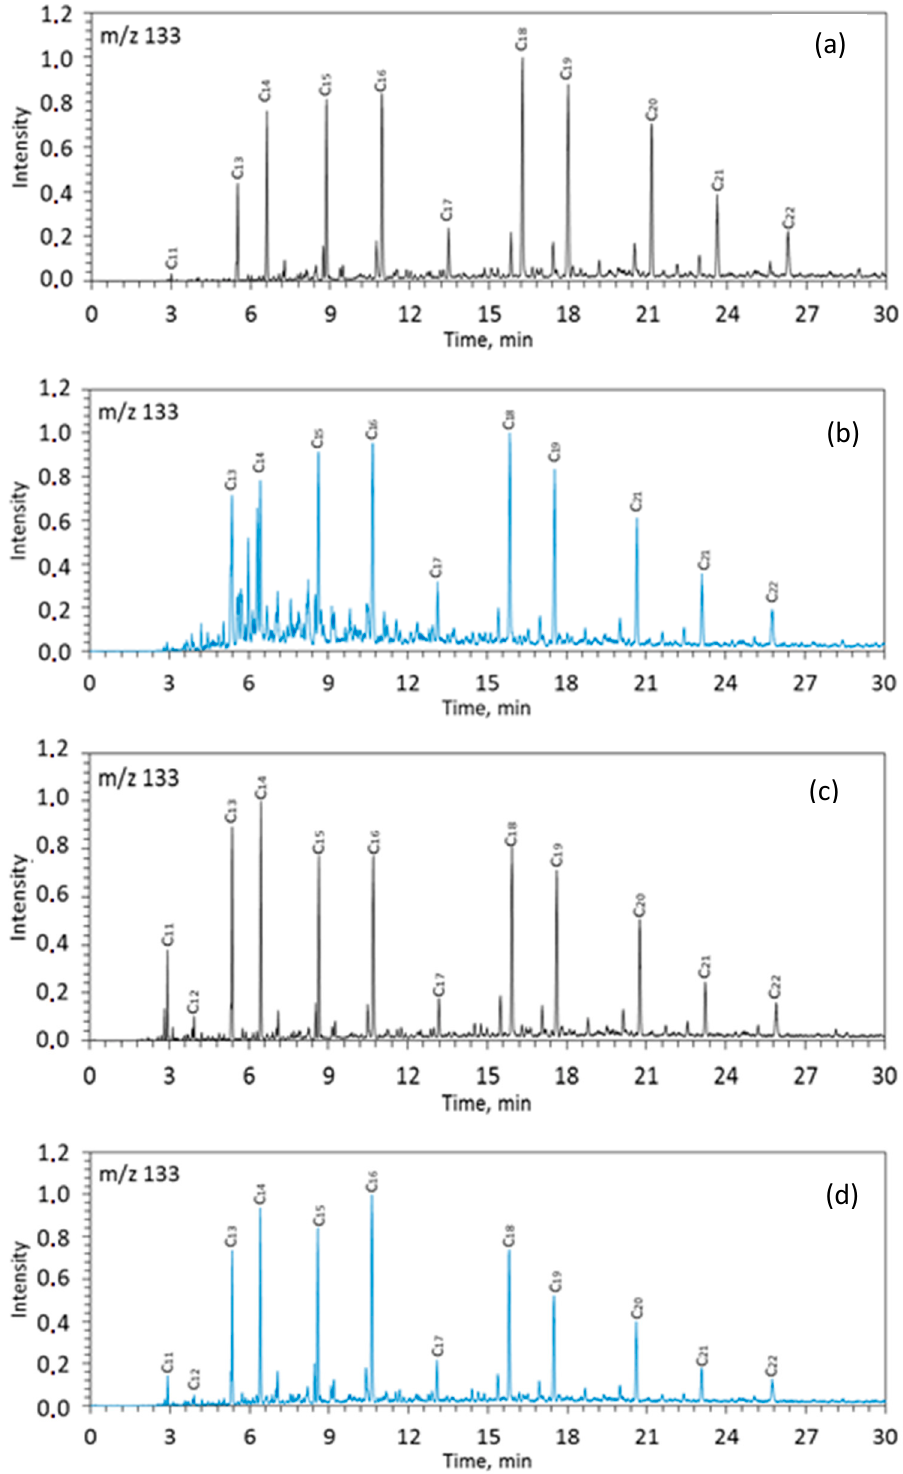
Figure 4. Mass-fragmentogram at m / z 133 for saturated fractions of rock samples from the Zelenogorskaya and Bere-